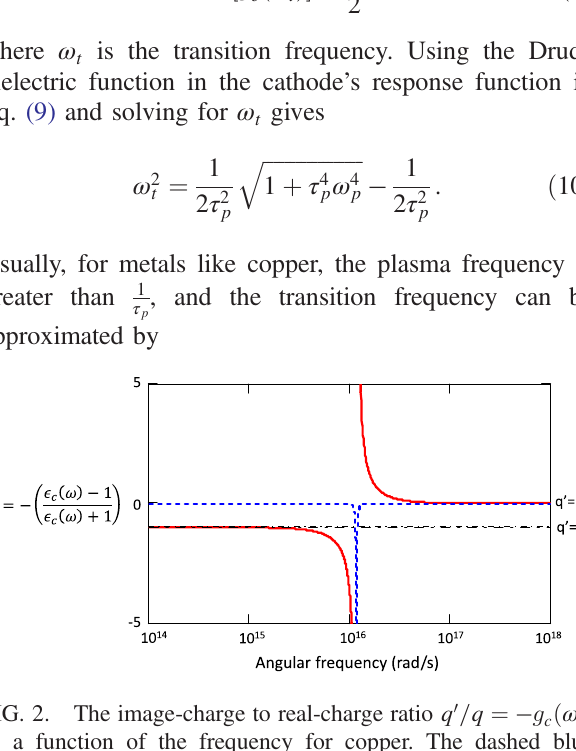
FIG. 2. The image-charge to real-charge ratio q 0 =q ¼ − g as a function of the frequency for copper. The dashed blue curve is the imaginary part, and the solid red curve is the real part. A dash-dot line is drawn at q 0 ¼ − q assumed in most current cathode models. The transition frequency for copper is ω 1 . 16 × 10 16 rad =